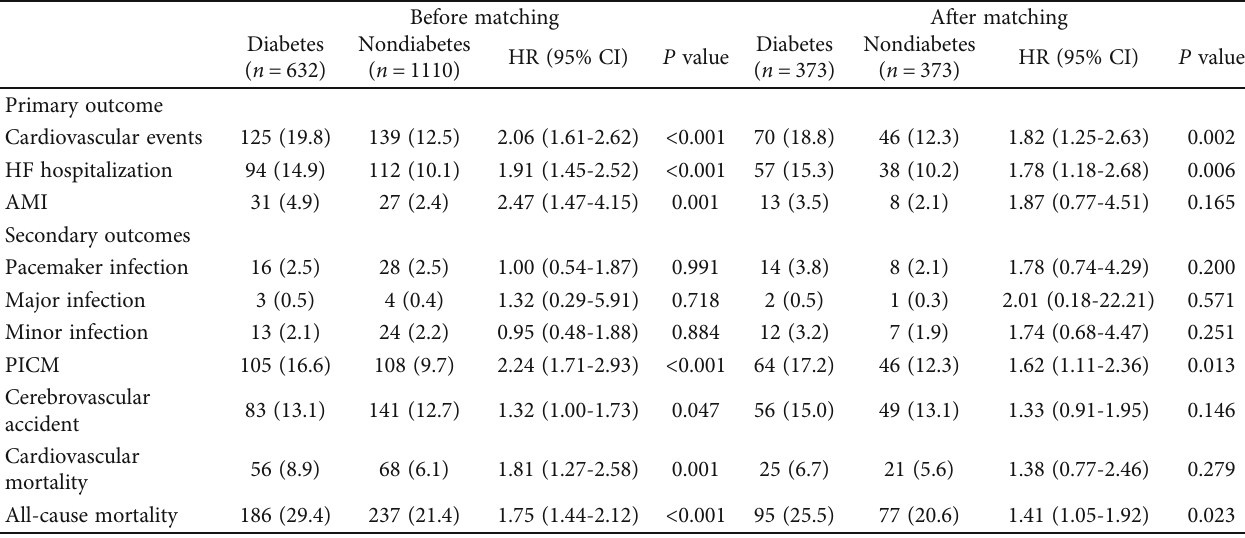
Table 2: Clinical outcomes of the patients with and without diabetes and univariate Cox regression analysis for hazard ratio of diabetes vs. nondiabetes for all outcomes during a nearly 8-year follow-up period. Before matching After